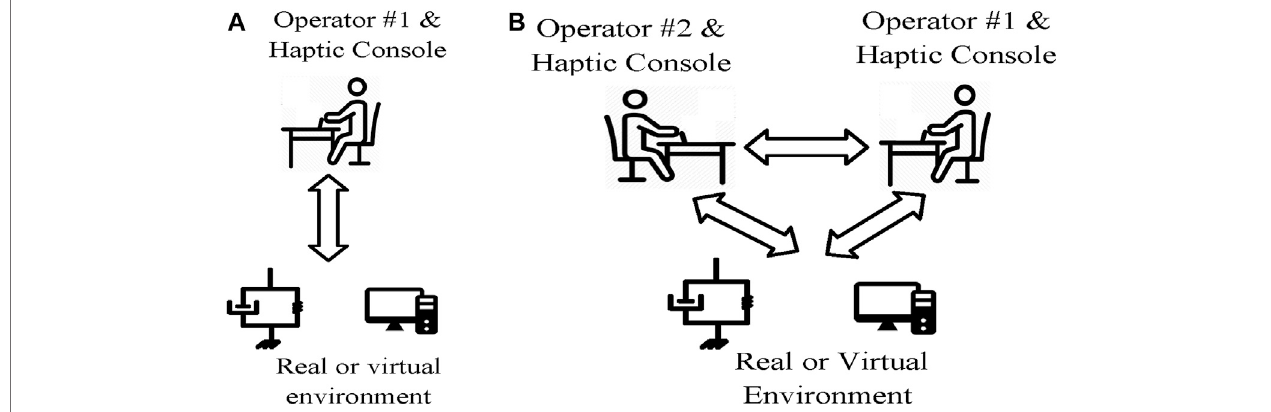
FIGURE 4 | Single user vs. dual user haptic systems. (A) Single user haptic system. (B) Dual user haptic system.